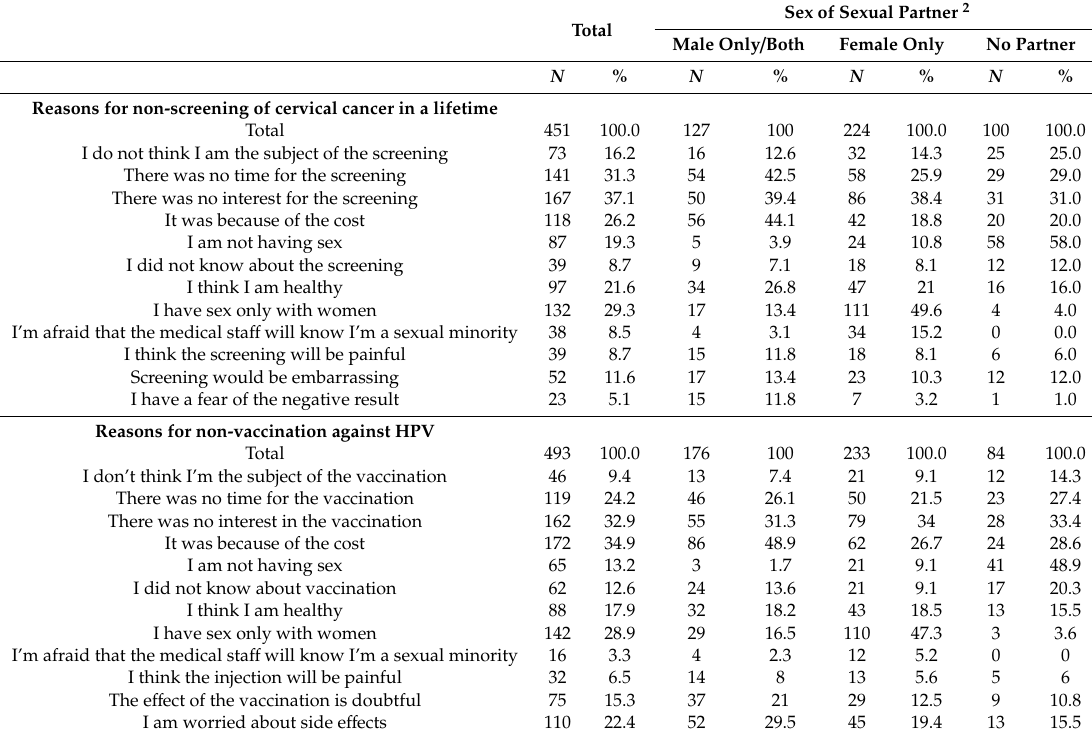
Table 4. Reasons for non-screening of cervical cancer and non-vaccination against HPV ( n = 451) 1